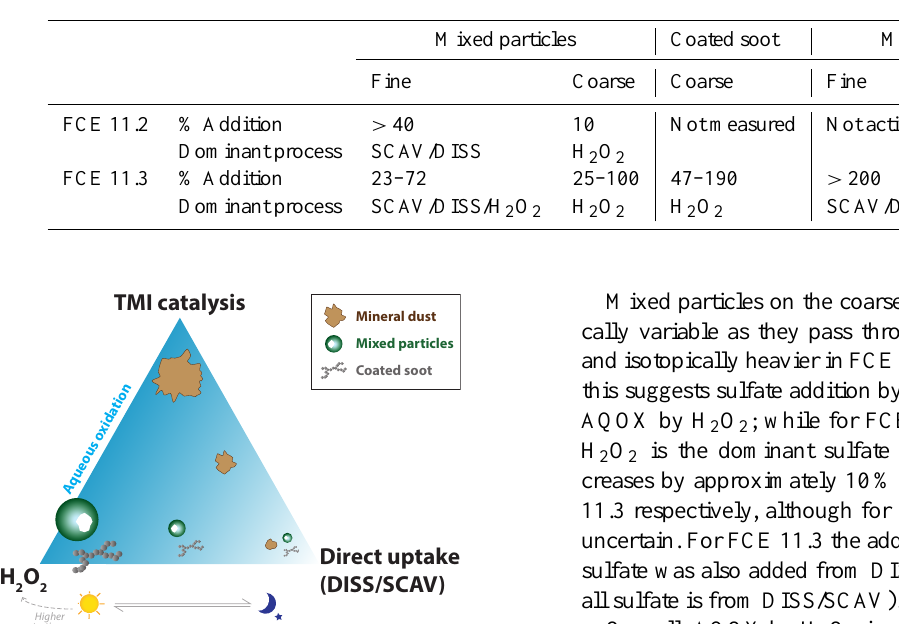
Table 5. Dominant sulfate sources to different particle classes observed with sulfur isotope analyses at HCCT-2010: H 2 O 2 and TMI-cat refer to in situ oxidation of SO 2 (AQOX). Percentage increases in sulfate concentration are approximate, and refer to surface sulfate for mineral dust and bulk sulfate for mixed particles and coated soot. “Coarse” and “fine” refer to particle size ranges of approximately > 600nm and 50–600nm respectively (see Sect. 3.2).